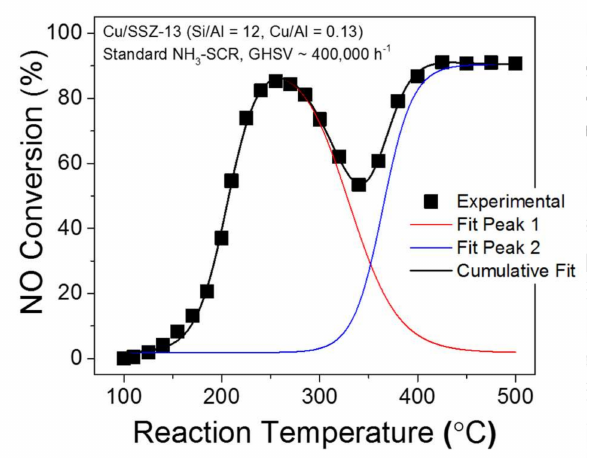
Figure 10. NO conversion versus temperature data ( (cid:4) ) for standard SCR over a Cu/SSZ-13 catalyst with Si/Al = 12 and Cu/Al = 0.13. The reactant feed contains 350 ppm NH 3 , 350 ppm NO, 14% O 2 , 2.5% H 2 O balanced with N 2 at a gas hourly space velocity (GHSV) of 400,000 h − 1 . Also included are simulated curves assuming low- and high-temperature reaction routes. Reprinted with permission from J. Am. Chem. Soc. , 2017 , 139 , 4935–4942. Copyright 2017, American Chemical Society.